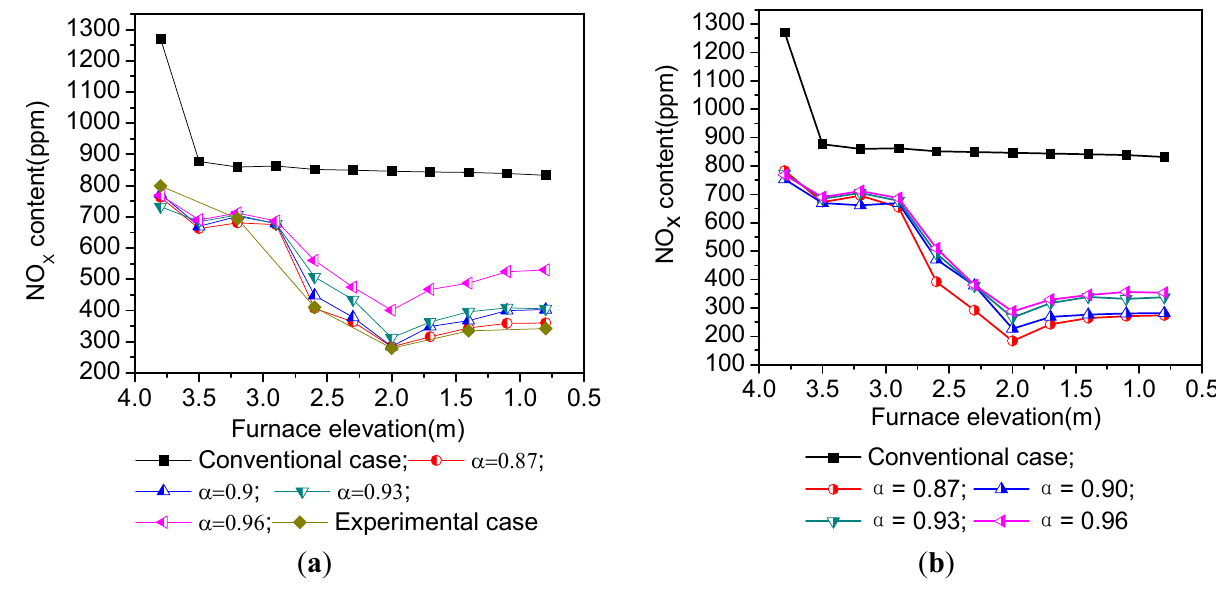
Figure 3. NO x distributions along with the height of the furnace under different α : ( a ) SAm reburning; and ( b ) cornstalk